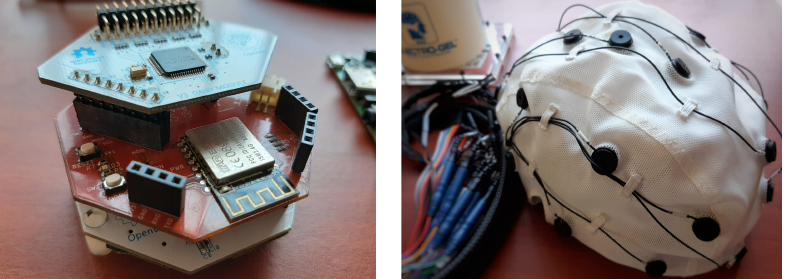
Figure 1. The OpenBCI system is equipped with a Daisy extension board and a WiFi shield for up to 16 channel support and 8 k SPS. It also includes an EEG cap with conductive gel for improved conductivity. Table 3. OpenBCI Cyton configurations using Daisy expansion board and Wi-Fi shield. OpenBCI